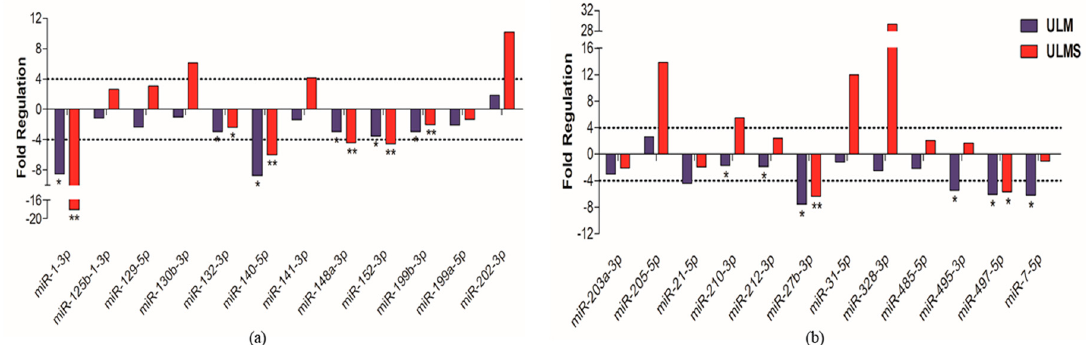
Figure 5. Analysis of 24 differentially expressed miRNAs in human samples. ( a , b ) Twelve miRNAs with significant expression in patients’ samples, having as reference MM tissue (cut-off +4 and − 4). Student’s t -test; * p < 0.05, ** p < 0.005, and *** p < 0.0005 (the error bars were not provided by software).